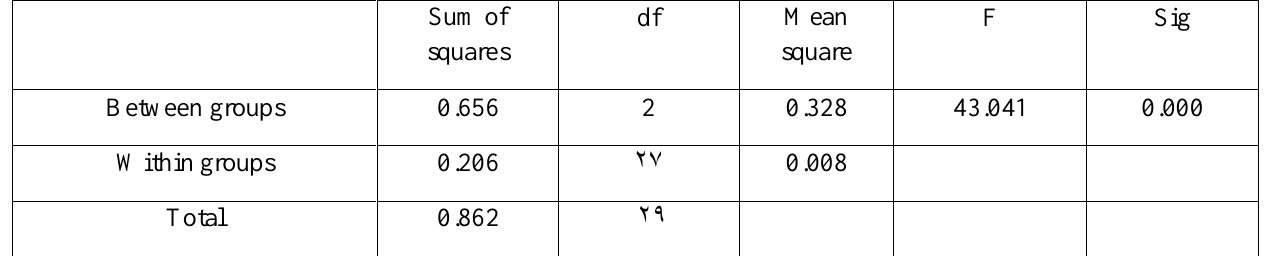
Table 7: One way ANOVA test of water sorption test(mg/cm 2